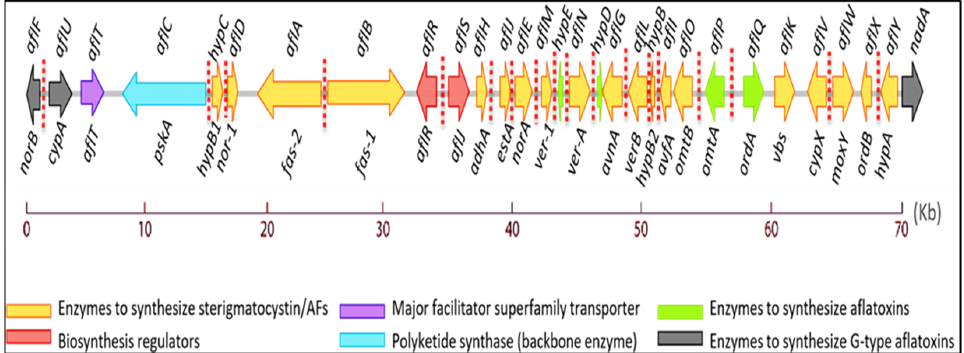
Figure 1. Organization of gene clusters of AFs’ biosynthesis pathway [21].